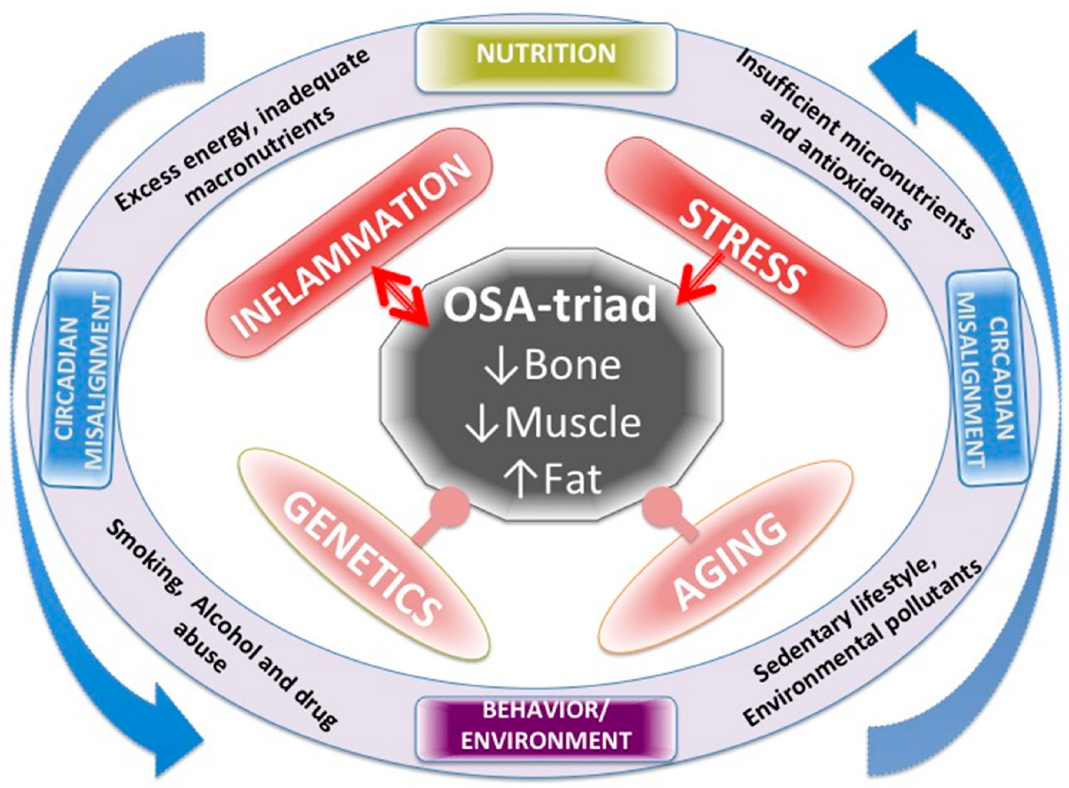
Figure 1. Various factors affecting body composition, presented as osteosarcopenic adiposity (OSA) and low-grade chronic inflammation (LGCI) as well as their mutual action on each other.